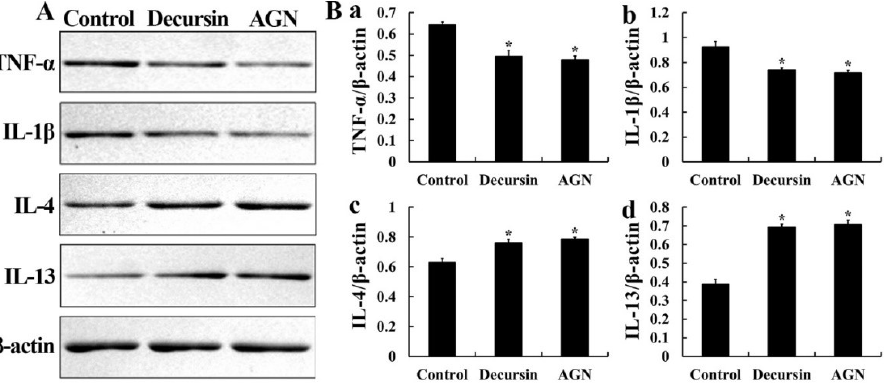
Figure 4. Representative blot images of TNF- α , IL-1 β , IL-4 and IL-13 ( A ) in mouse dorsal skin and each protein expression normalized to β -actin ( Ba – d ) ( n = 7 in each group; * p < 0.05 versus control group). The bars indicate the means ± SEM.